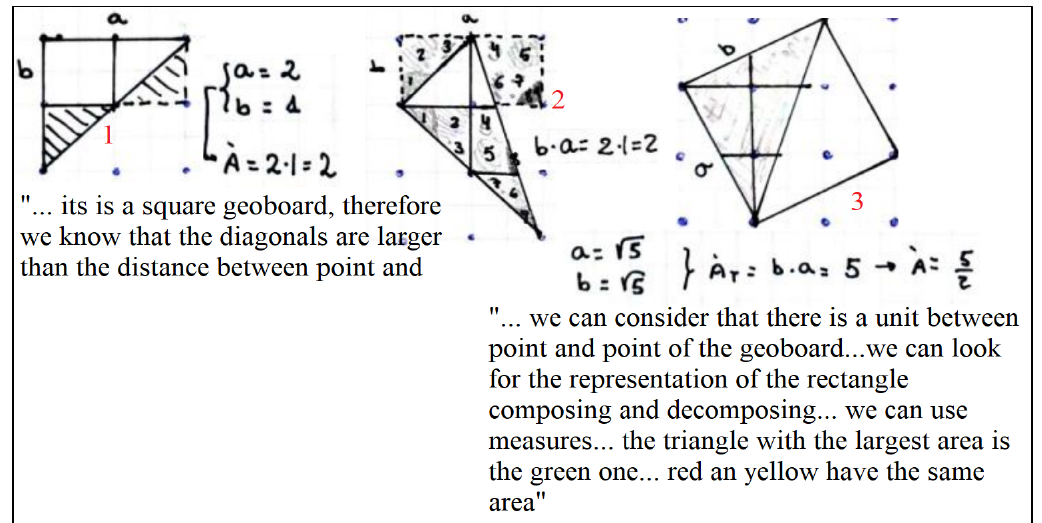
Figure 8. Resolution of a PST to Task 4.